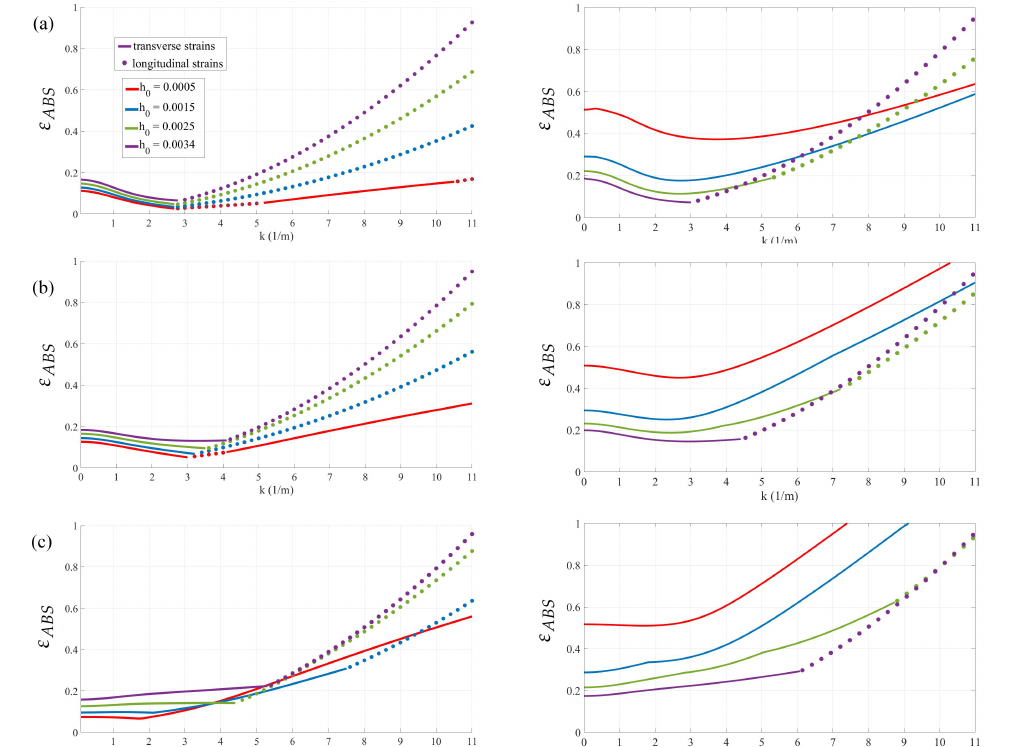
Figure 10. The scaled absolute maximum strains, ε ABS = max ε max ( y ) for the first three modes as functions of k for 4 different values of h 0 (see legend). Here, ( a )—first mode, ( b )—second and ( c )—third one. The results for Case 1 are shown on the left of the figure, for Case 2, on the right. The longitudinal strains are shown by the dotted line (markers), transverse strains—by the solid line. The scale is A / ( 2 b 2 )